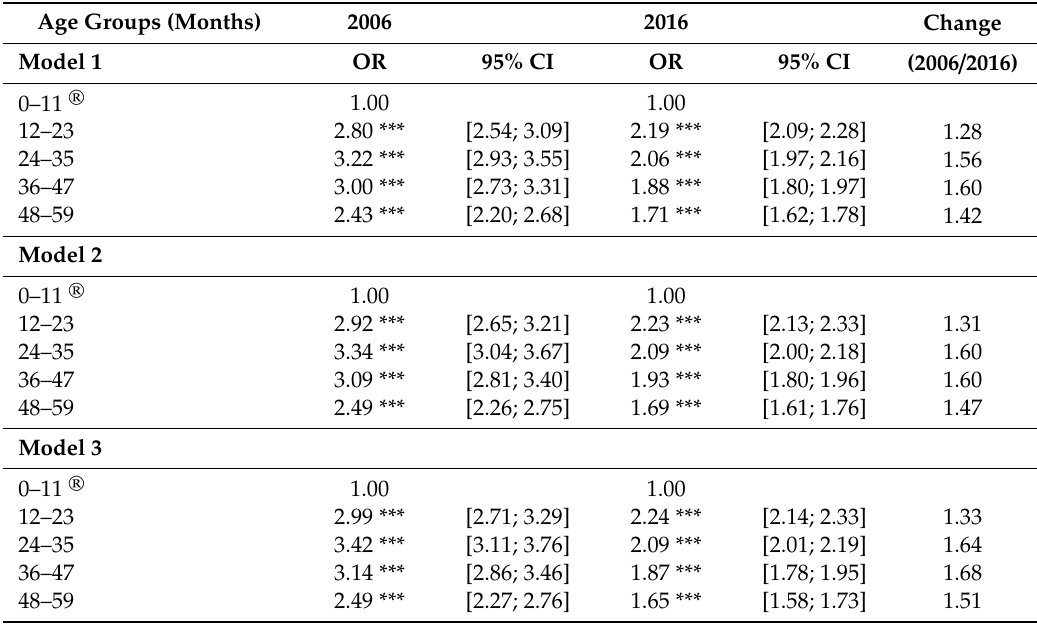
Table A4. Econometric association between severe stunting among children (below five years) and age groups, India, NFHS 2006, and 2016.